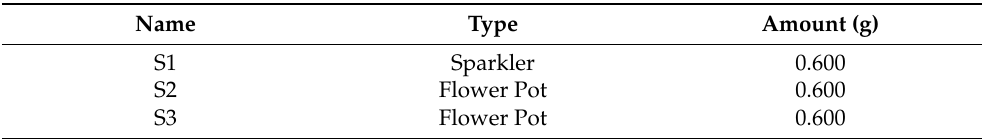
Table 1. List of the green crackers used for the analysis.